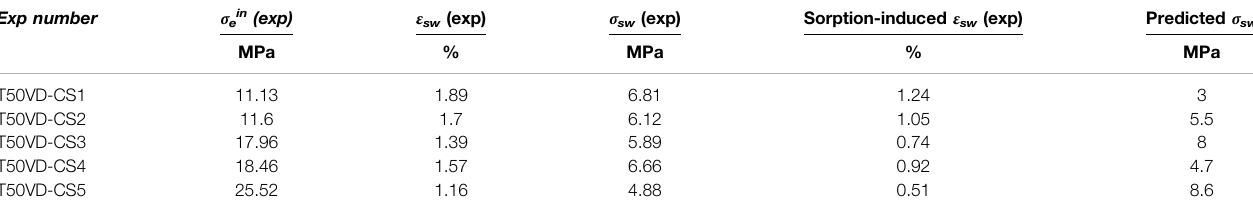
TABLE 4 | Comparison of model prediction with experimental data on swelling stresses measured for VD SWy-1 samples exposed to CO 2 pressure at 10 MP at 50 ° C (Zhang, 2019). Exp number σ ein (exp) ε sw (exp) σ sw